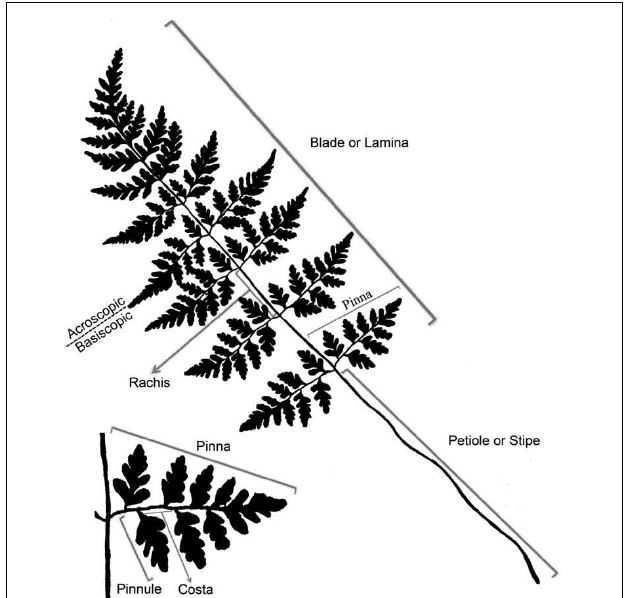
FIGURE 5 | Terminology of a typical fern leaf or